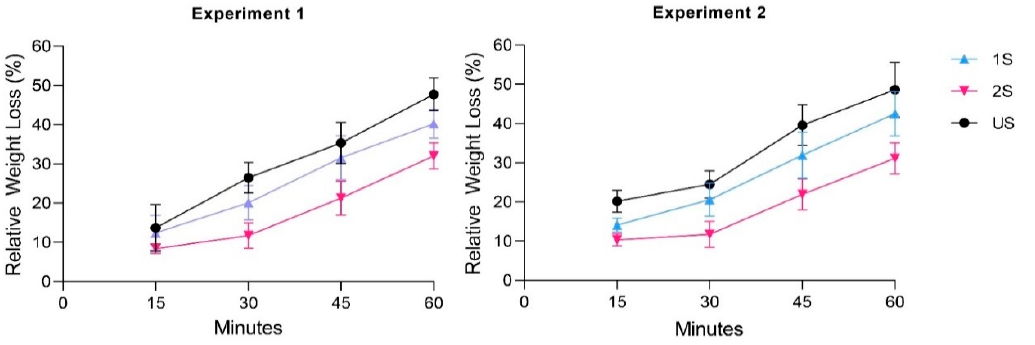
Figure 3. Rates of fresh weight loss over an hour from a detached leaflet of the top trifoliate leaves of primed (2S), unprimed (1S) and unstressed control (US) soybean C08 plants relative to the initial fresh weight immediately after detachment. n = 12 plants. Error bars indicate standard deviation.